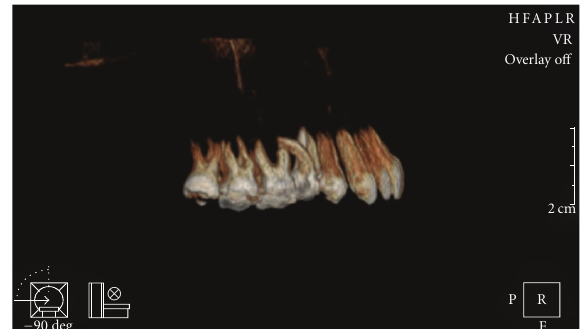
Figure 4: Reconstructed cone-beam computerized tomography image showing right side of the maxilla.